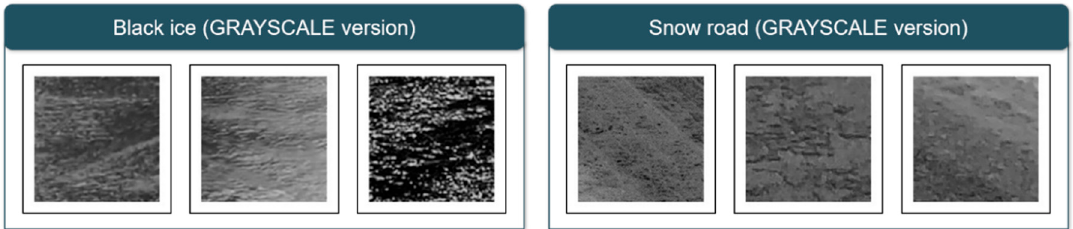
Figure 7. RGB version of train data (black ice and snow road); in the case of black ice, it can be seen that it shimmers due to light reflection, and in the case of snow data, snow crystals and slush appear.